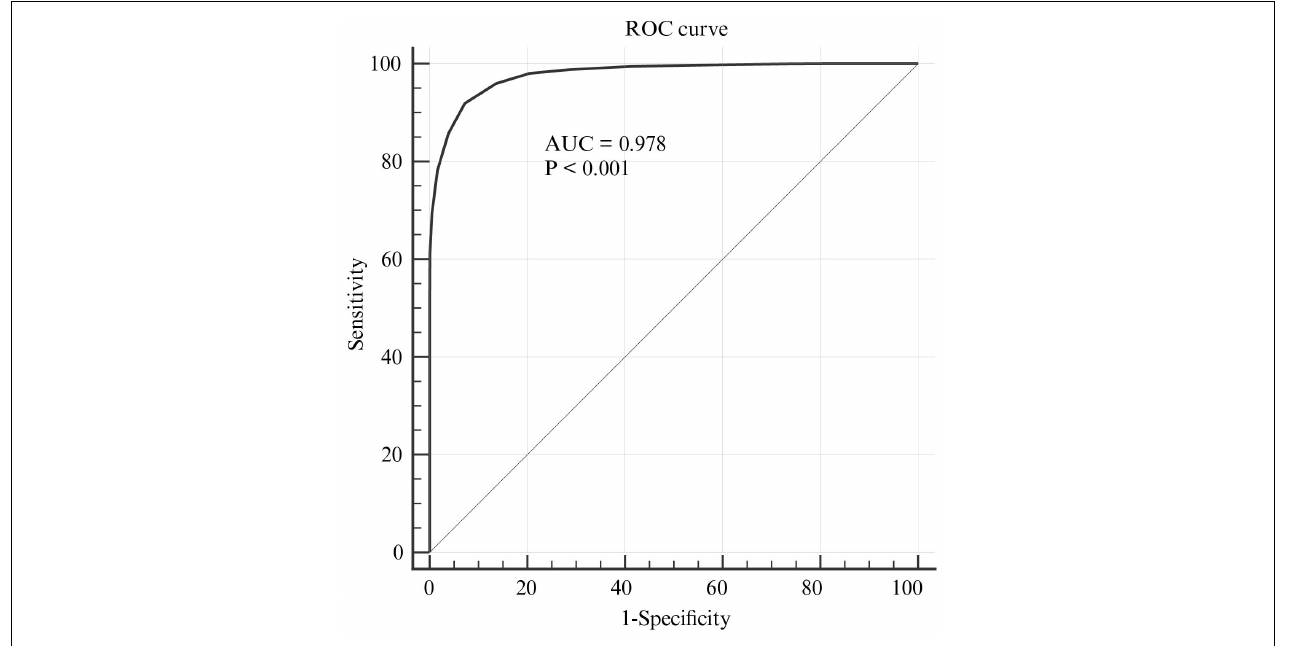
FIGURE 3 | The ROC curve of the CES-D-10 for screening depression. ROC, receiver operating characteristic; CES-D-10, 10-item Center for Epidemiologic Studies Depression Scale.